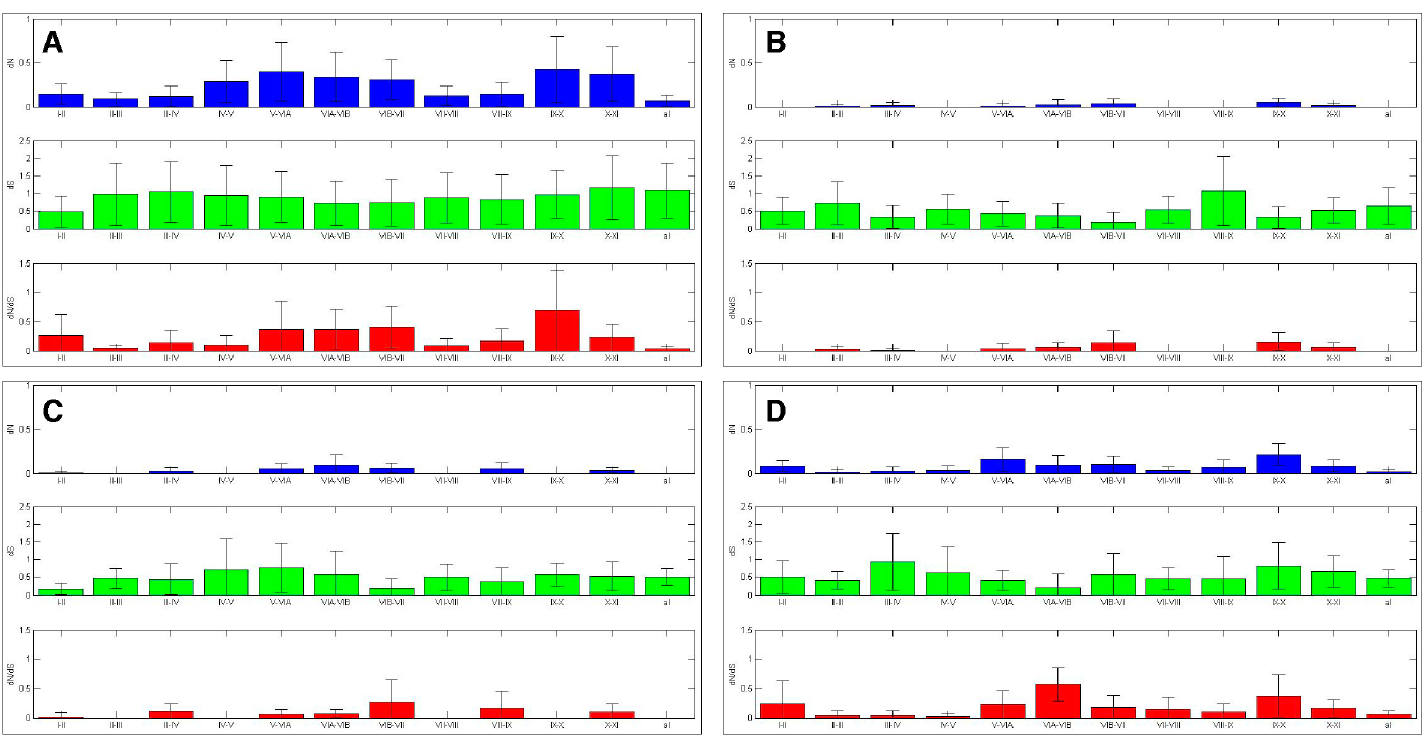
Figure 7. AK kinase interdomains experienced differential selection. The selection experienced by the AK interdomains and activation loop was calculated. The bars represent average value, while the error bars represent plus or minus one standard deviation for dN (top), dS (middle), and dN / dS (bottom), this analysis was carried out with ( A ) the entire AK gene family, ( B ) AKA , ( C ) AKB and ( D ) AKC .